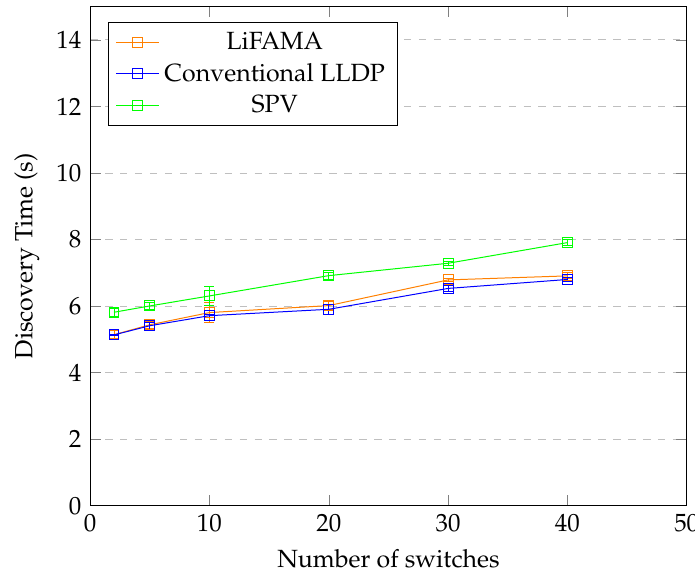
Figure 13. Custom topology